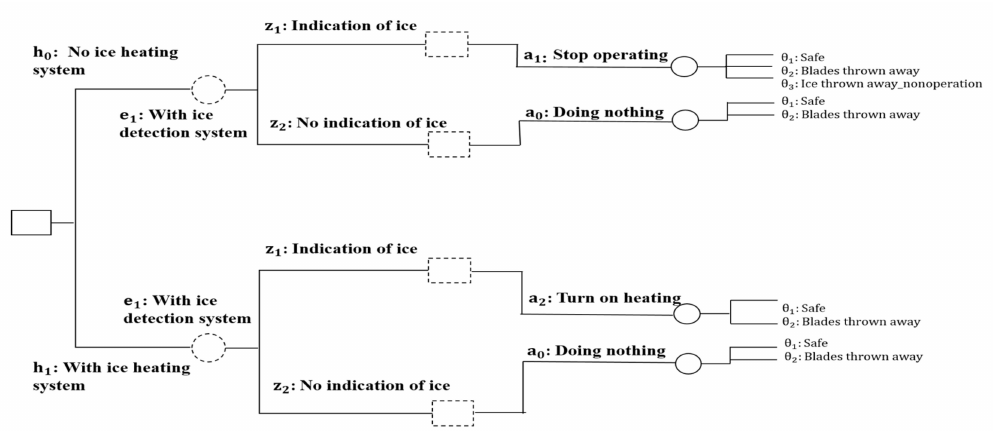
Figure 8. Illustration of the modeled decision scenario and utilized models. A dashed decision node (rectangle) stands for the use of a decision rule and a dashed chance node (circle) for the use of perfect information provided by the ice detection system.